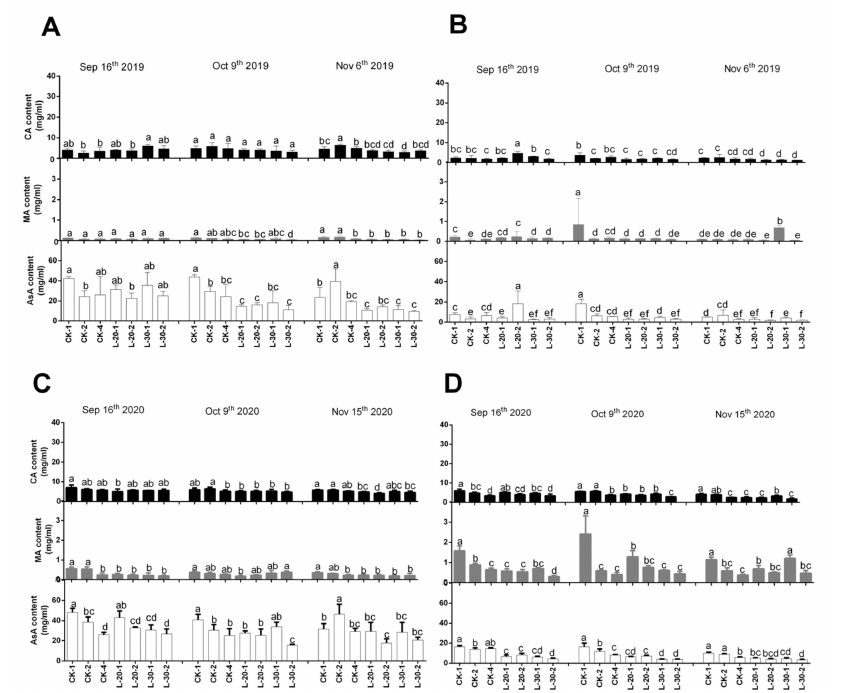
Figure 3. Comparison of changes of organic acid components and contents of peel ( A , C ) and flesh ( B , D ) under different fruit load treatments from the near-mature period (mid-September) to the fully-mature period (mid-November) (CA: citric acid; MA: malic acid; AsA: ascorbic acid). Within columns, means with the different letter indicate significant differences ( p < 0.05) using Duncan’s test; bars on the columns represent the standard error of the mean ( n =